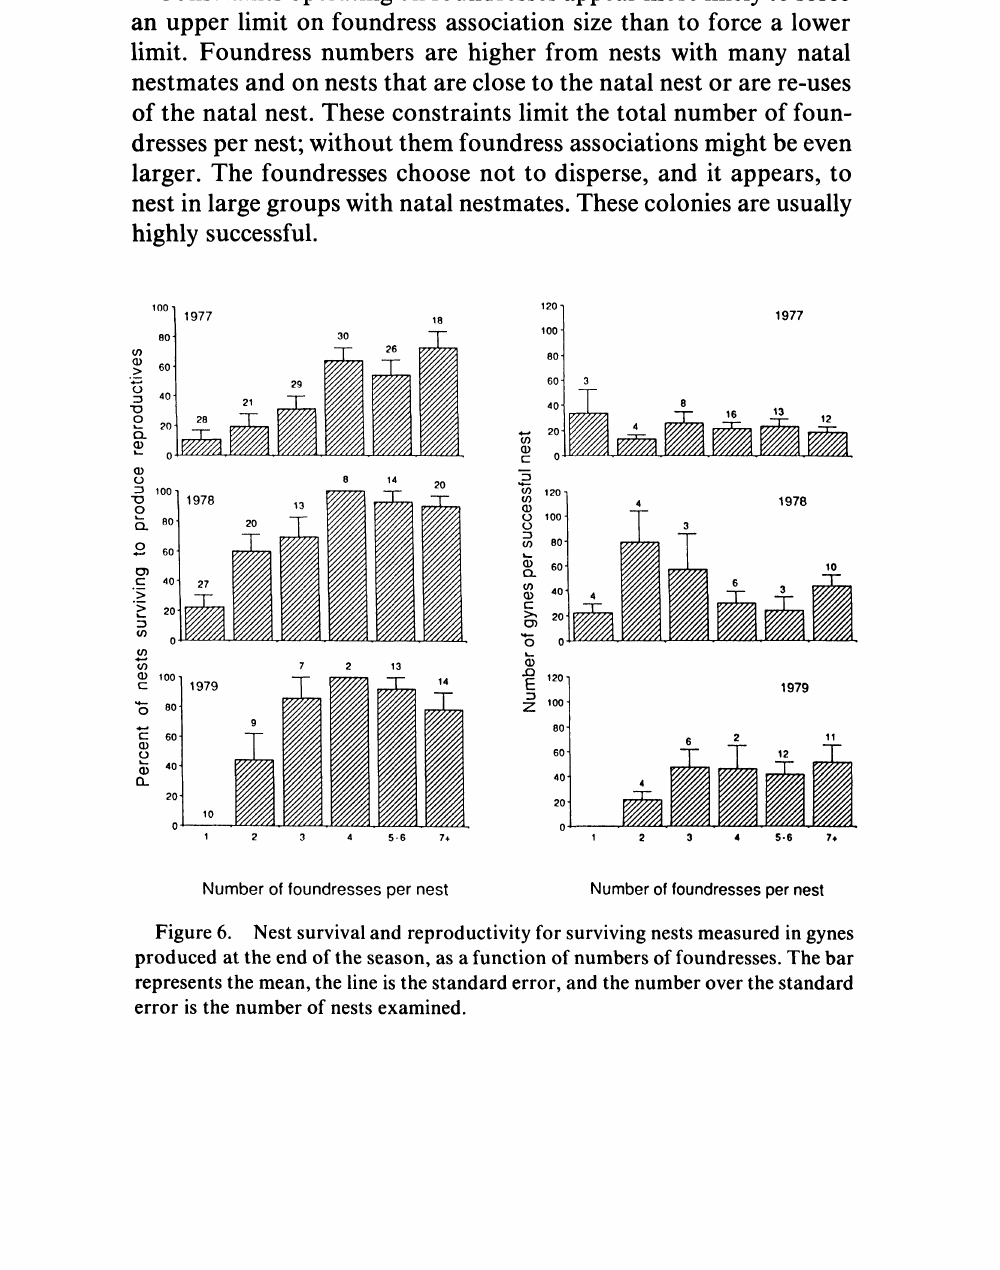
Figure 6. Nest survival and reproductivity for surviving nests measured in gynes produced at the end of the season, as a function of numbers of foundresses. The bar represents the mean, the line is the standard error, and the number over the standard error is the number of nests